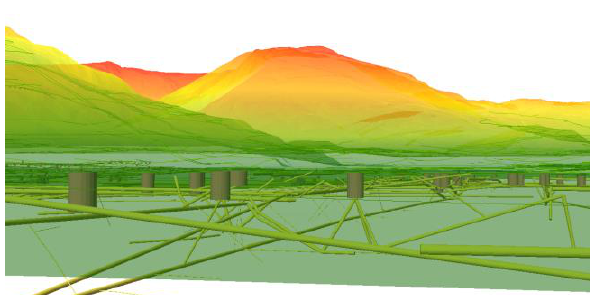
Figure 9: The "Swiss cheese" of energy wells (A.